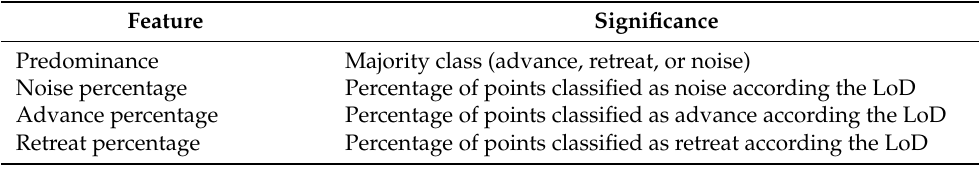
Table 2. New features computed with the adaptation of the algorithm DBSCAN. The results are incorporated into the cluster event as cluster feature. Feature